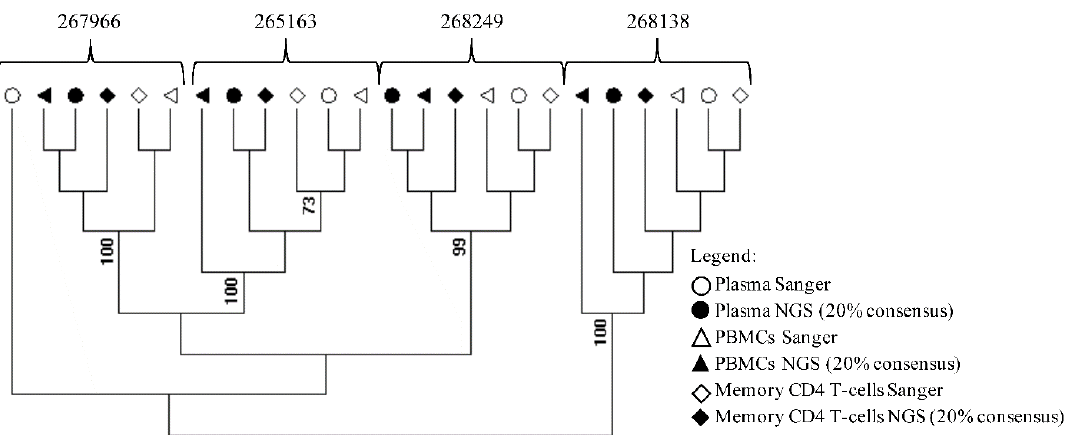
Figure 2. Phylogenetic assessment of cross-contamination in study samples. An HIV-1 pol gene (protease and reverse transcriptase) maximum likelihood tree was created by using MEGA software v6 from samples processed by Sanger- and NGS-based methods (consensus 20%). The blood compartment and sequence methodology are indicated by symbols.